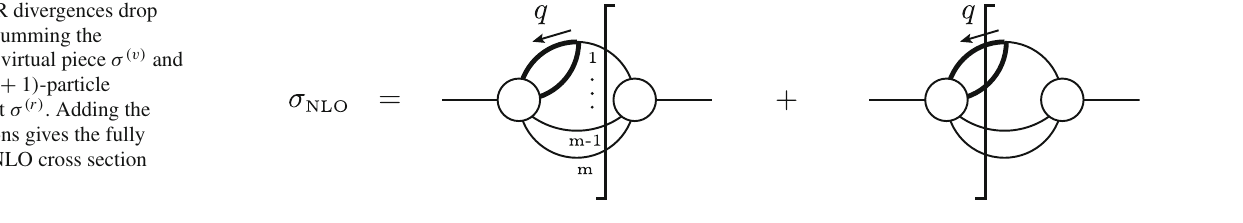
(cid:22) s ij ¯ s i < j ij s ij